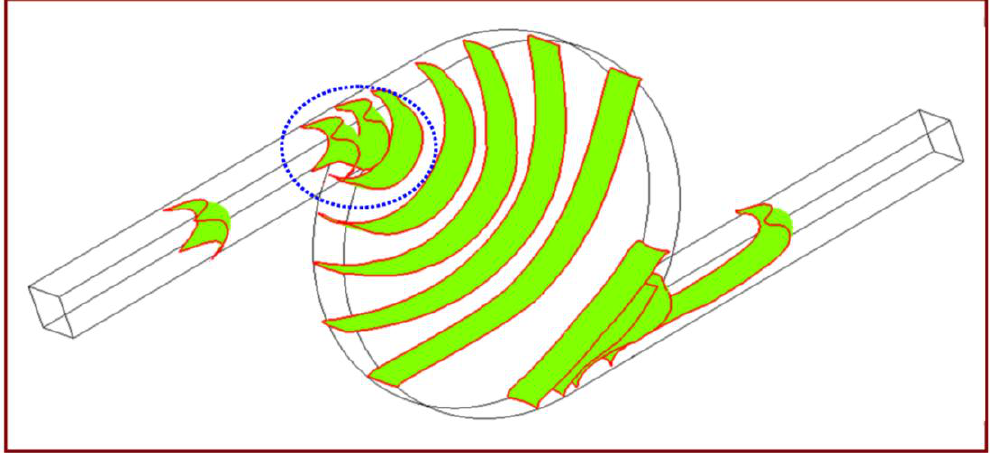
Figure 8. Filling process for the single ramp model when K is 350° s/m, θ and θ is uc